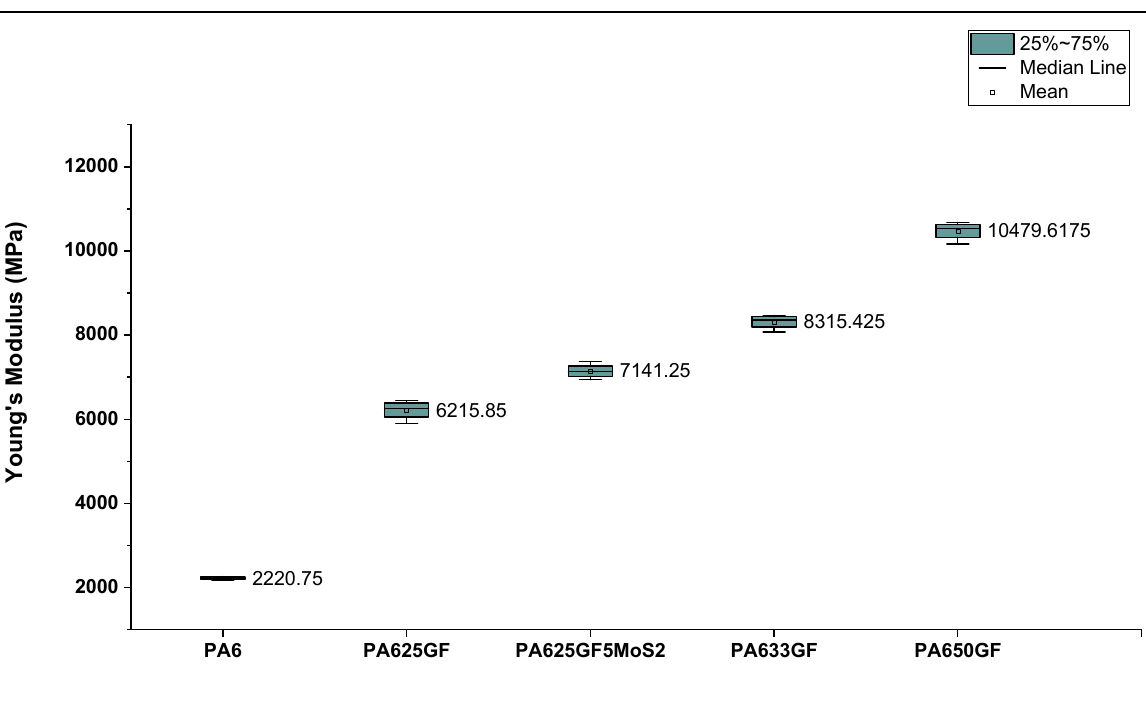
Figure 5. Elastic modulus for PA6 and PA6 reinforced with glass fibres at varied fibre volume fractions.